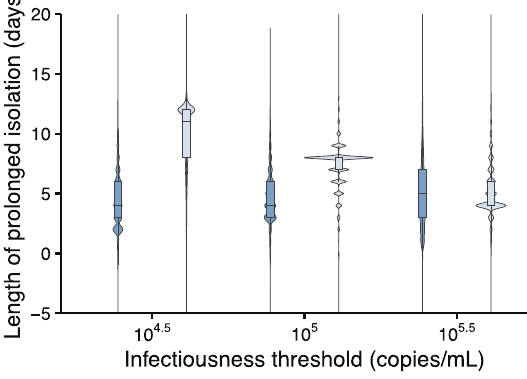
of consecutive negative results necessary to end isolation were selected to mini- mize the duration of prolonged isolation. b The same as a , but considering a 1% or lowerrisk of prematurely ending isolation. Note thatthe estimate values are based on 100 simulations with 1000 patients each for symptomatic and asymptomatic cases, respectively. Accordingly, 1000 parameter sets were sampled from the posterior distribution of each model